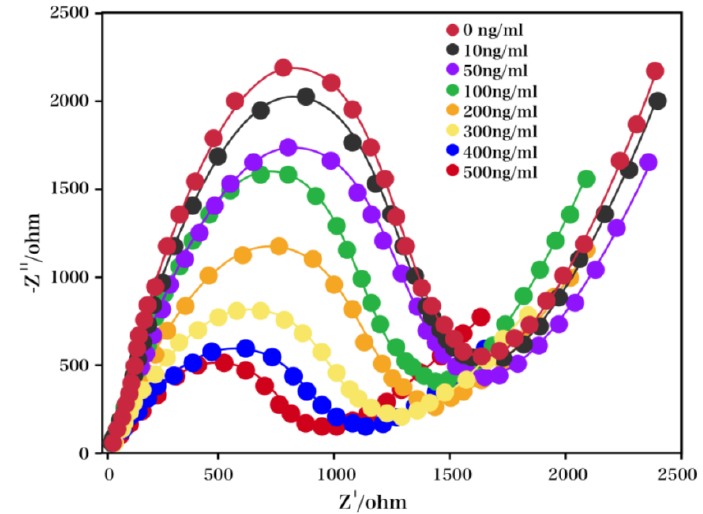
Figure 3. Electrochemical impedance response recorded for CPE/TiO 2 /(CS+AuNPs)/anti-ProGRP/BSA/ProGRP immunoelectrode as a function of ProGRP concentration over the range of 10 to 450 ng/mL.